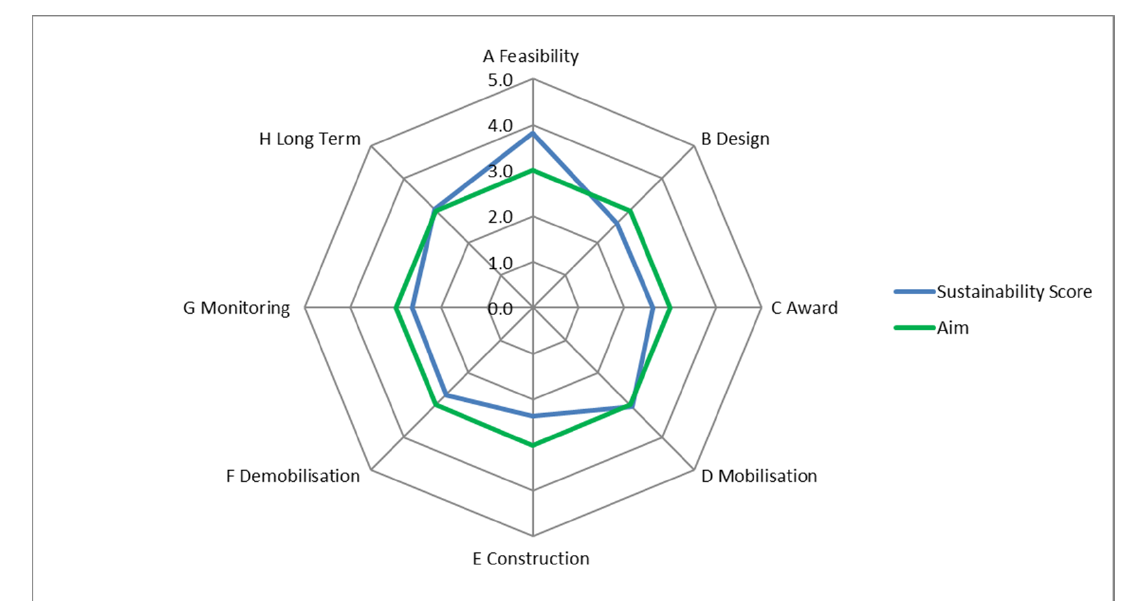
Figure 4. Average scores for coastal case studies (4).